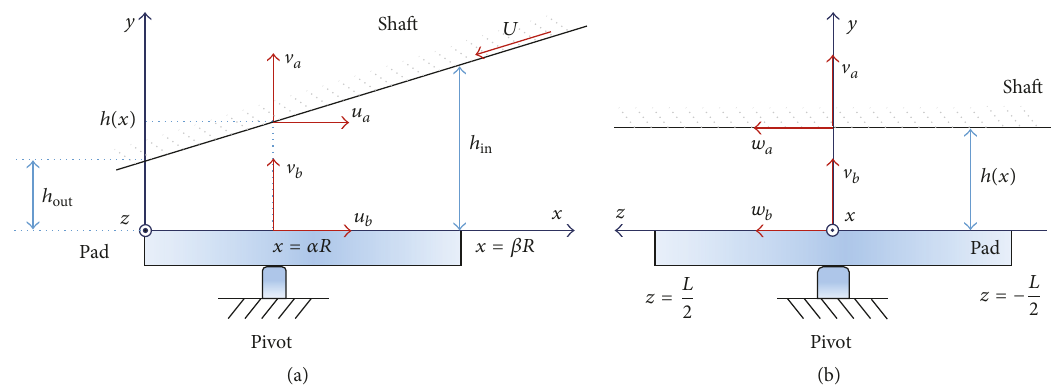
Figure 5: Elementary hydrodynamic model for LHG journal bearing: (a) view from axial direction; (b) view from sliding direction.